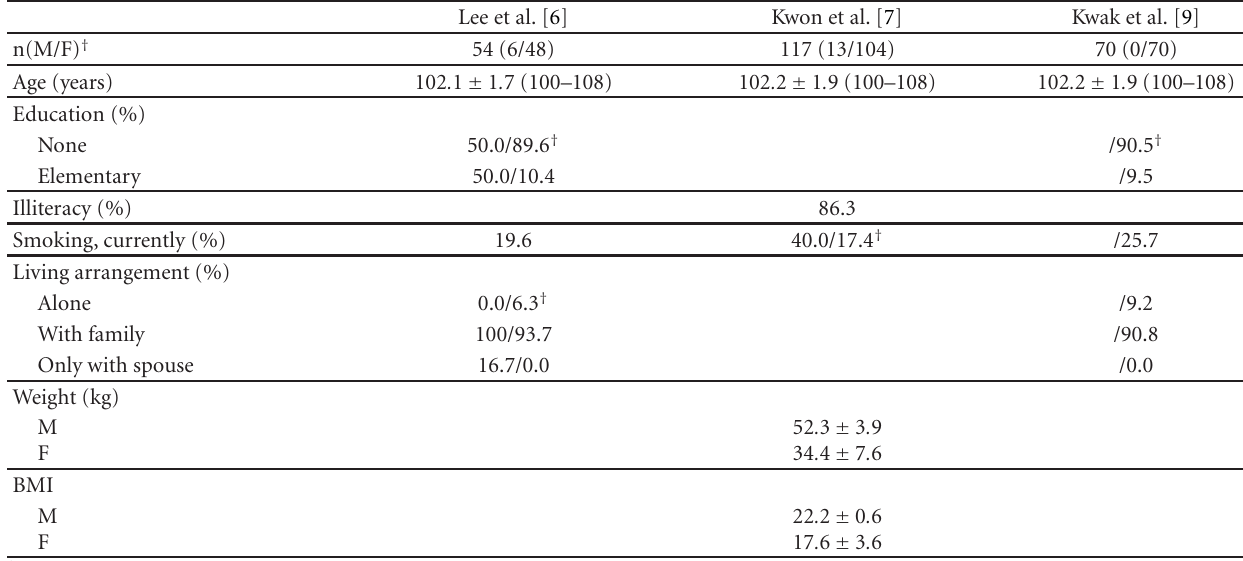
Table 1: Characteristics of Korean centenarian